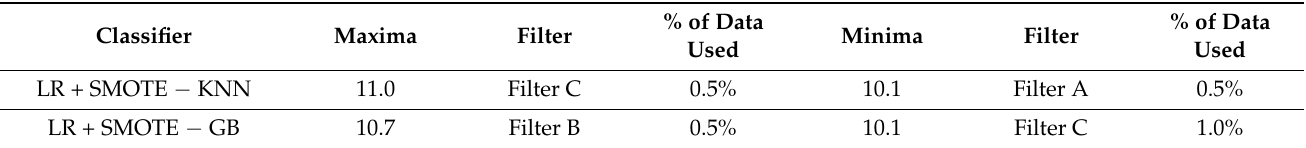
Table 2. Enrichment Ratios of ADORA2A on the original dataset with no feature selection with training size of